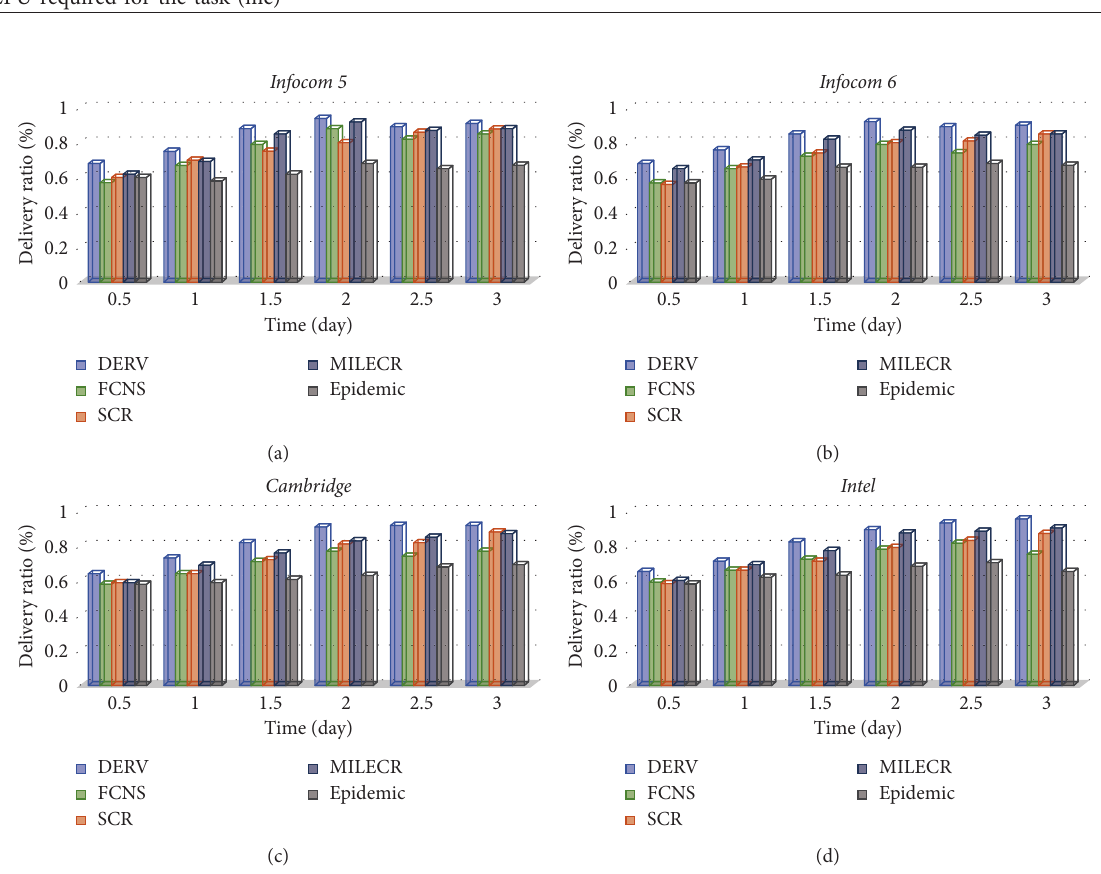
Figure 3: (a)–(d) The packet transfer ratios of the DERV, FCNS, SCR, MILECR, and epidemic algorithms on datasets Infocom5, Infocom6, Cambridge,